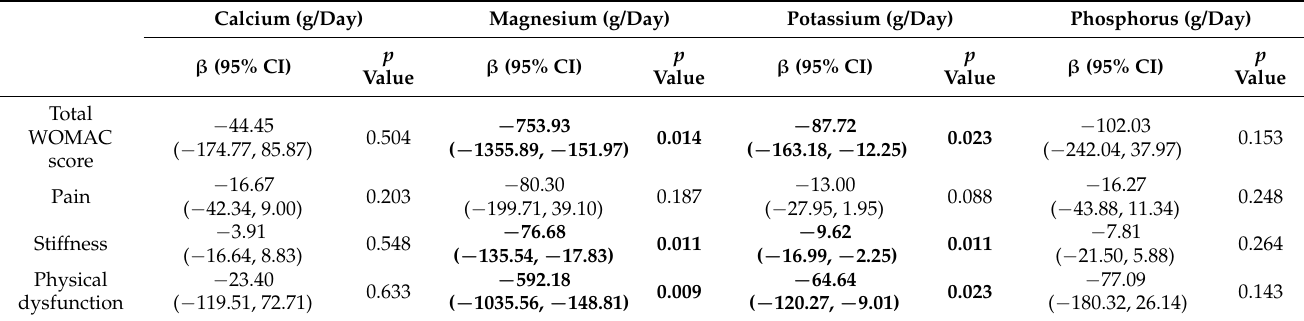
Table 3. Associations of macroelements with WOMAC score over 2 years.